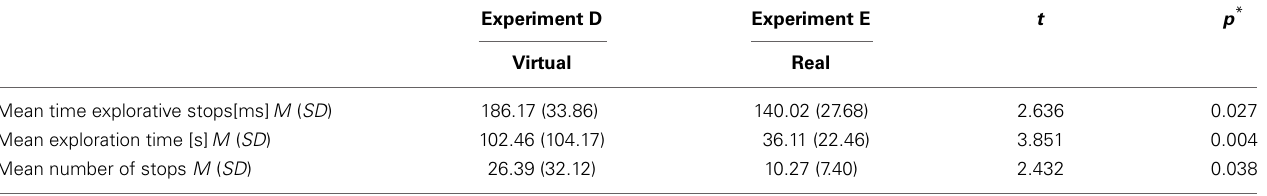
Table 3b | Description of experimental data and statistical comparison between virtual stimuli (Experiment D) and real stimuli (Experiment